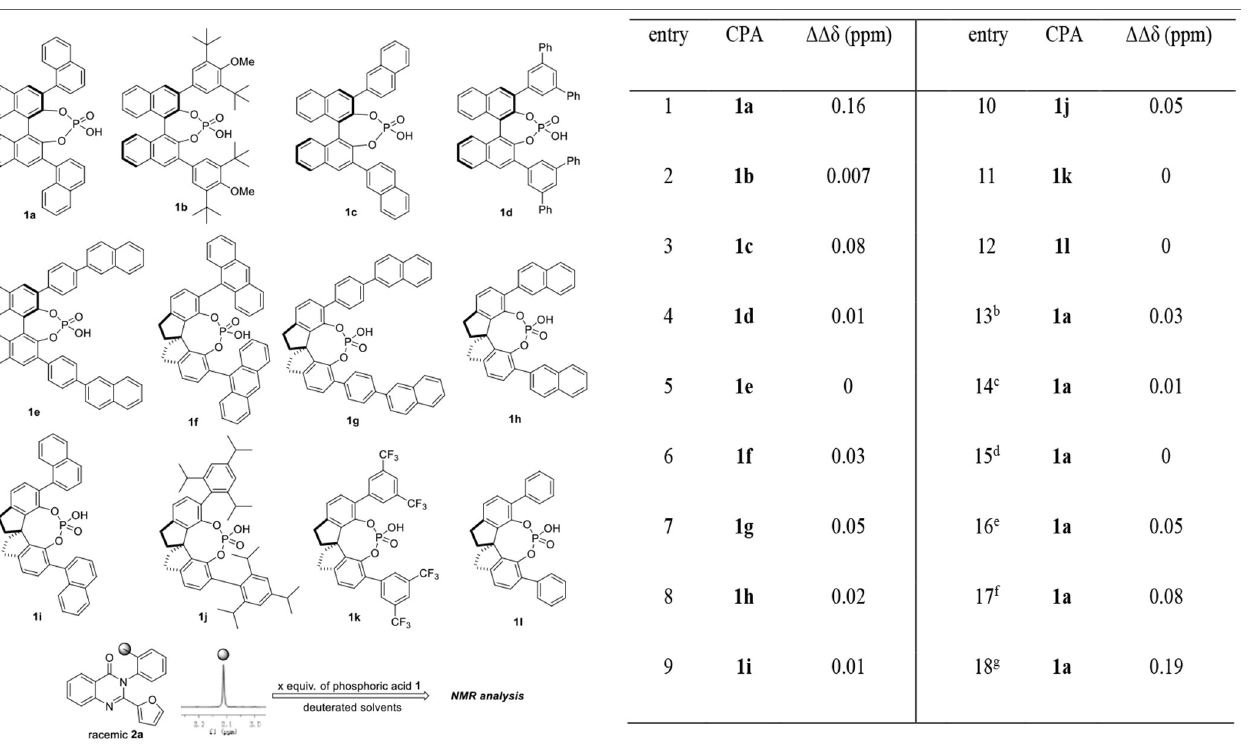
TABLE 1 | Evaluating the chiral recognition abilities of chiral phosphoric acids 1 with 2a